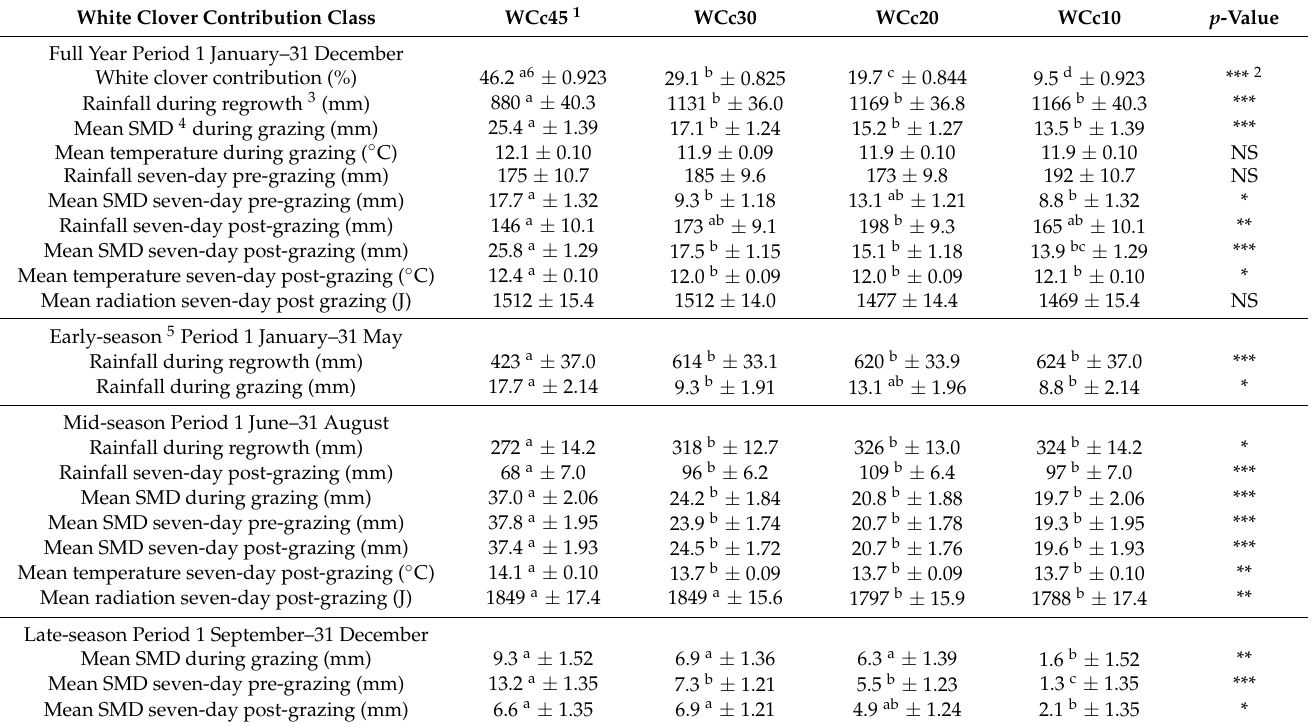
Table 4. Comparison of incident meteorological conditions for paddocks of different white clover contributions (WCc) before, during and after each grazing from 2014–2017, summarised for different grazing